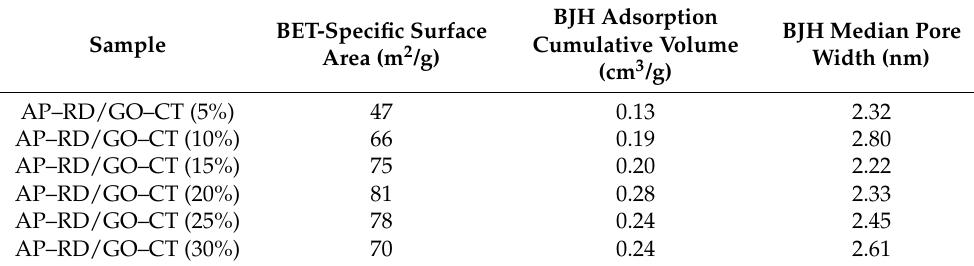
Table 2. The BET-specific surface area, BJH adsorption cumulative volume and BJH median pore width of Chitosan aerogels doped with different compounds. CT represents the